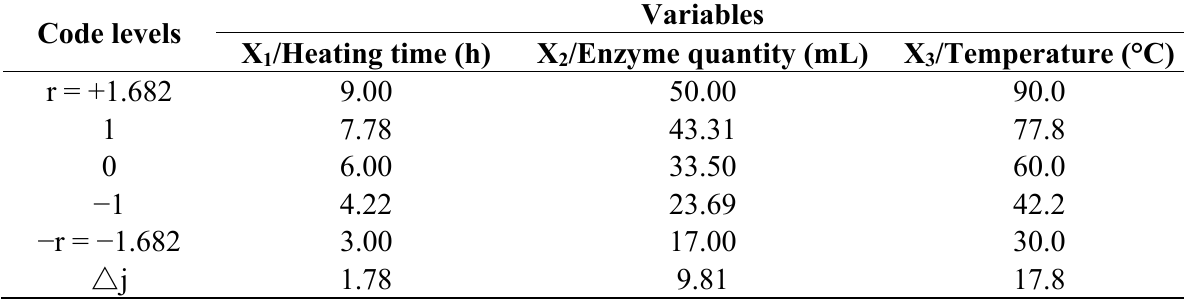
Table 4. Experimental design for the optimization of vanillin